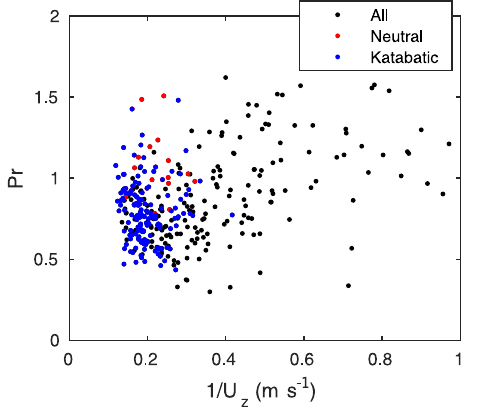
u ∗ , and C log K Int . Red (blue) points show values during near-neutral (katabatic) , C M − O z L L